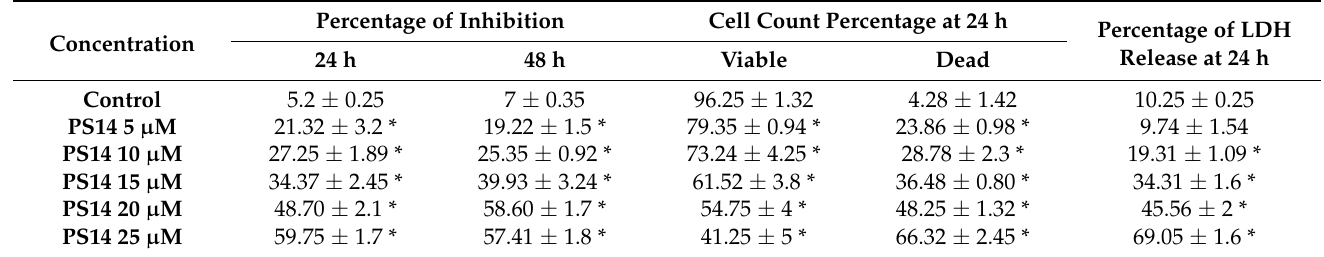
Table 1. In vitro anti-cancer activity of PS14 against Hep-2 cells. Anti-cancer activity was determined based on the results of MTT, Trypan blue exclusion and LDH release assays. Control represents untreated